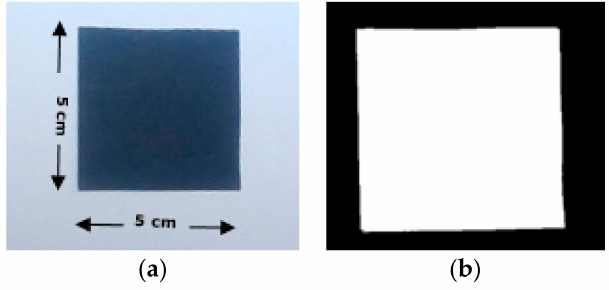
Figure 7. ( a ) The 5 cm × 5 cm calibrator and ( b ) its result from RGB to the intensity image.